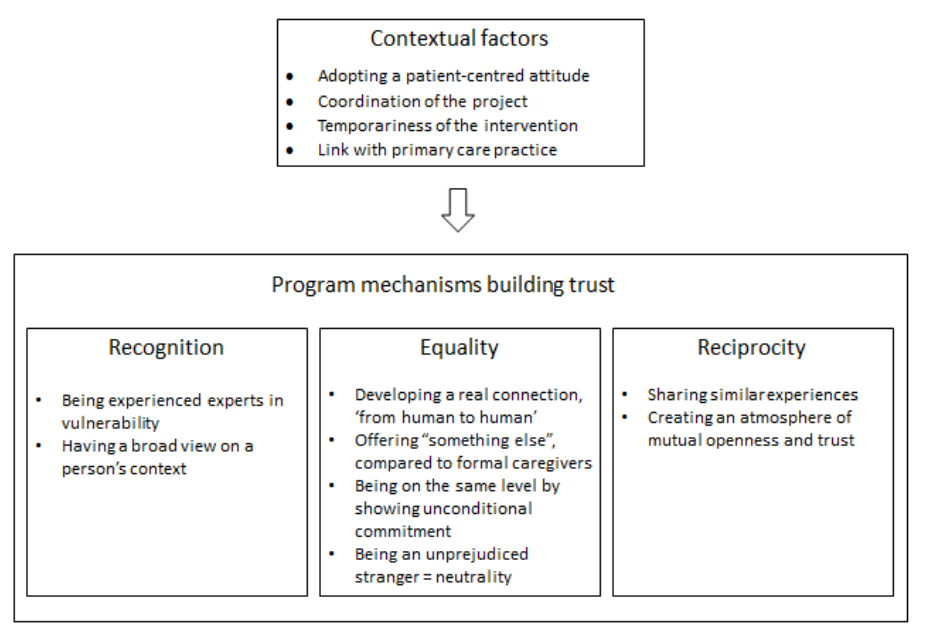
Figure 2. Contextual factors and program mechanisms producing outcomes.